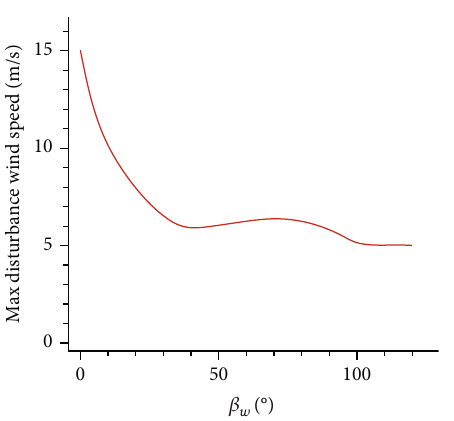
Figure 25: The maximum discrete wind speed that the Quad-Plane can reject at di ff erent β